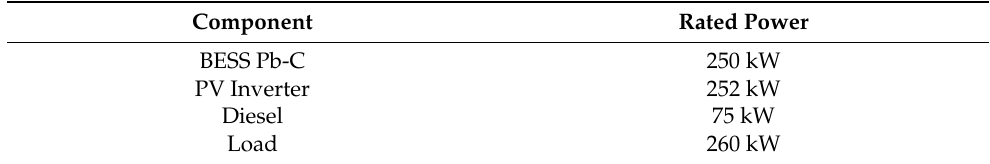
Table 1. ITEMM microgrids’ main